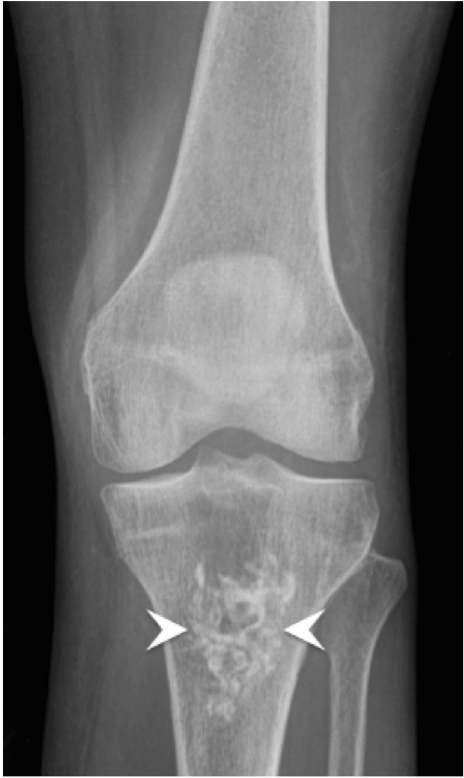
Fig.5 Enchondroma.Anteroposterior radiograph ofthe left knee showsa typical chondroid matrix mineralisation with arcs and rings in the tibia